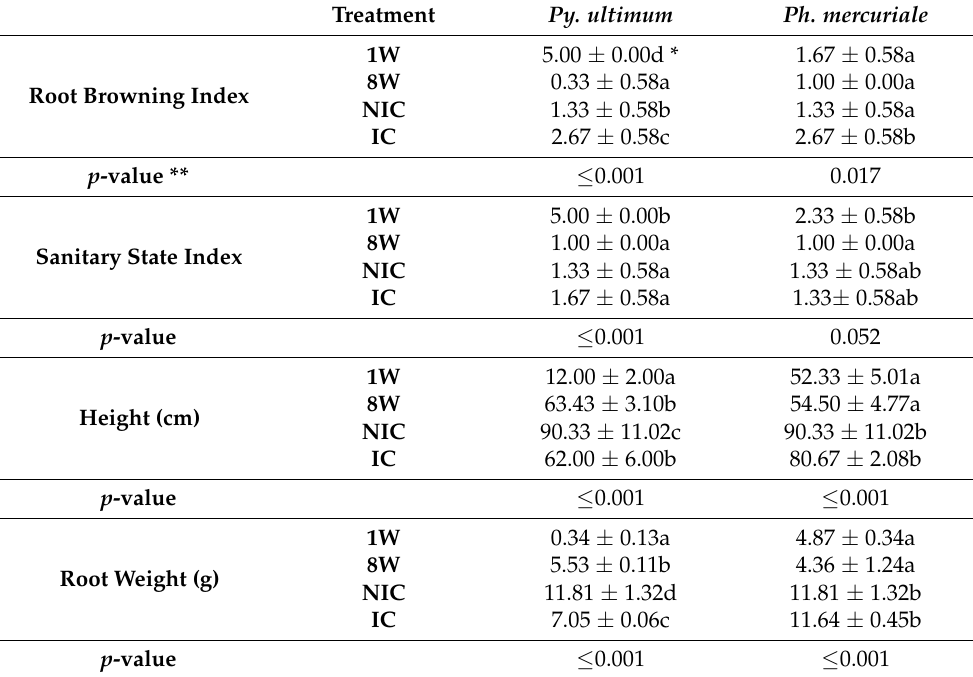
Table 3. Effect of Raphanus raphanistrum on the severity of pathogens associated to apple seedling decline on apple seedlings ‘MM106’ and seedlings growth three months after the inoculation.